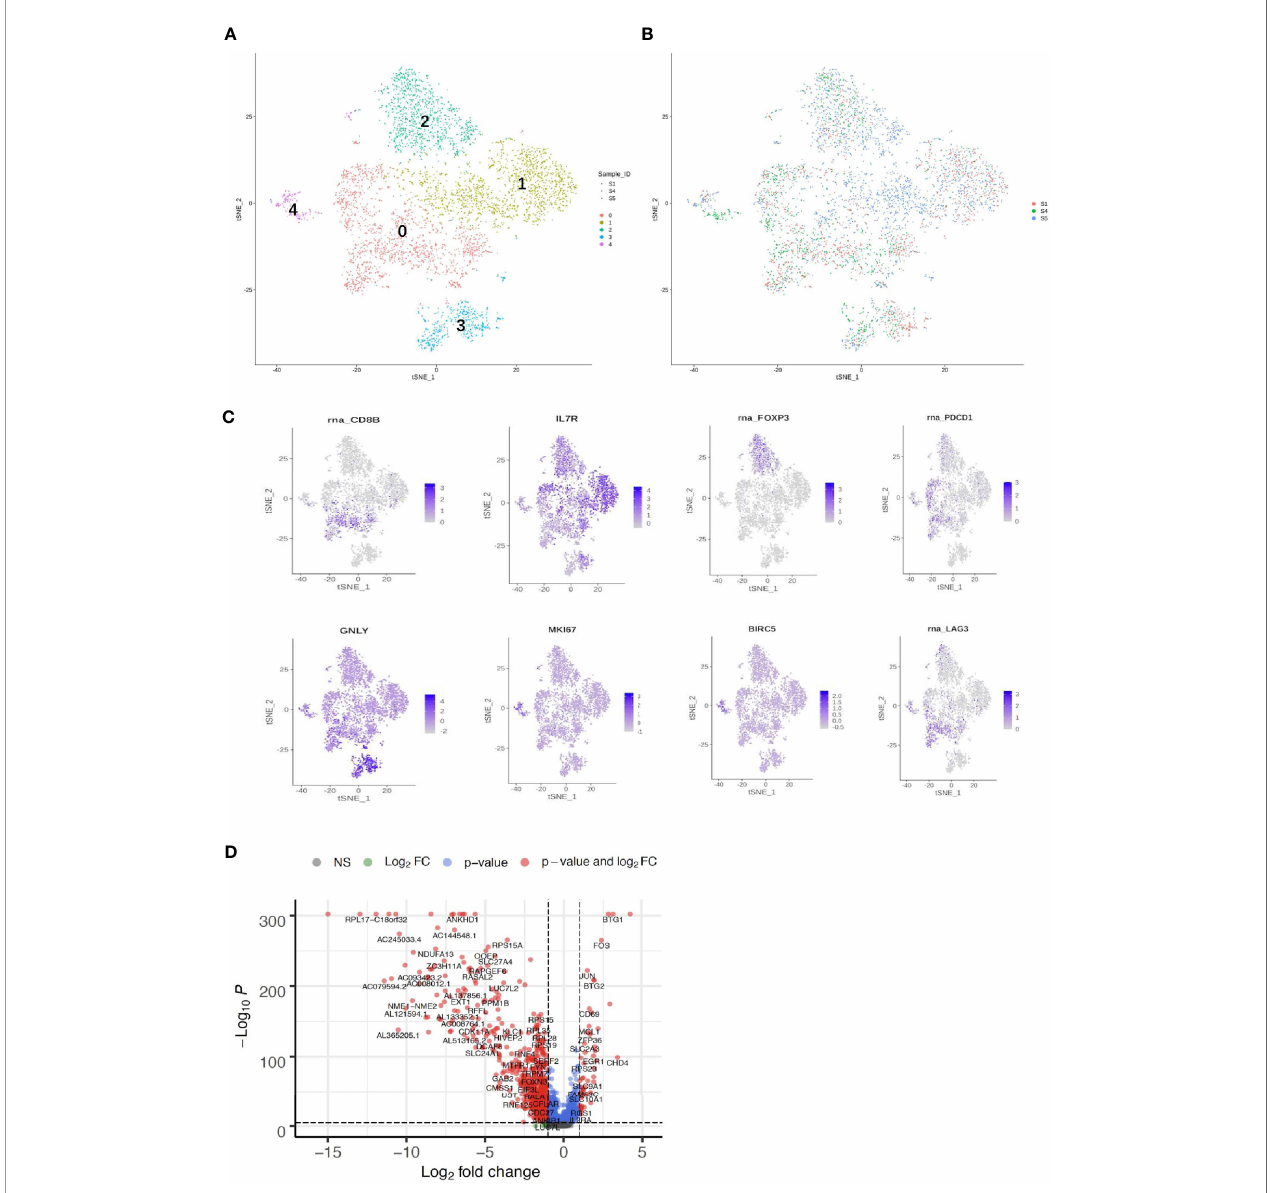
FIGURE 6 | Single-cell RNA sequencing (scRNA) pro fi les of T-cell lineages. Reclustering of 4,961 T cells color-coded by (A) clusters and (B) sample origin (right). (C) t -Distributed stochastic neighbor embedding ( t -SNE) plot color-coded for marker gene expression (gray to white to blue) for CD8 + (cluster 0, C0), CD4 + (C1), IL2A (C2), GNLY (C3), MKI167 , and BIRC2 (C4). (D) Volcano plot shows differentially expressed marker genes (rows) between chemoresistant patients and chemosensitive